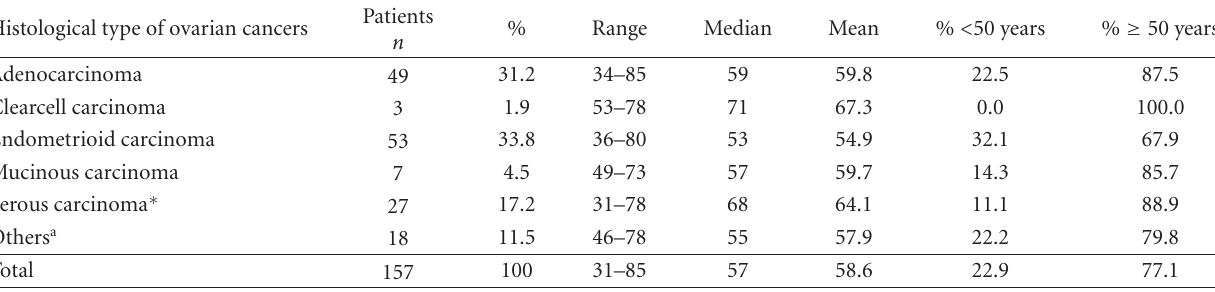
(b) Subset of epithelial ovarian cancers with malignancy in the endometrium.